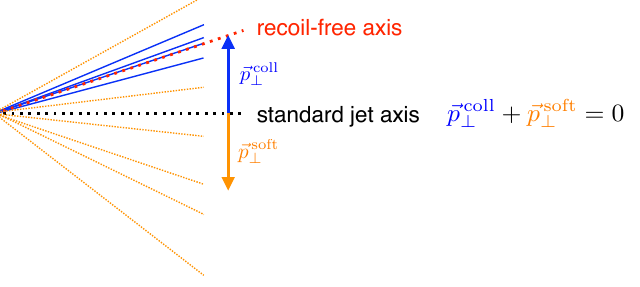
Figure 1 . The standard jet axis is sensitive to soft radiation (orange) through recoil e(cid:11)ects, whereas a recoil-free axis follows the direction of collinear radiation